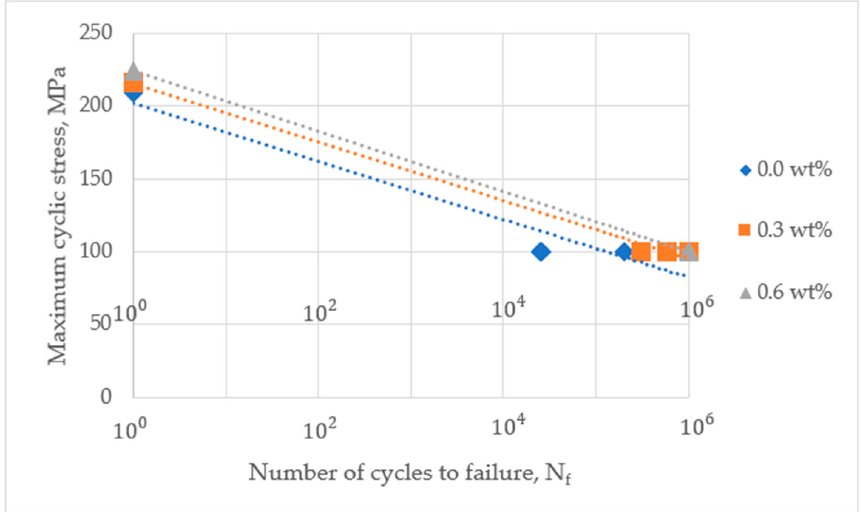
Figure 18. The number of cycles to failure of composite reinforced by 3 mm carbon fiber length under cyclic loading. J. Compos. Sci. 2019 , 3 , x